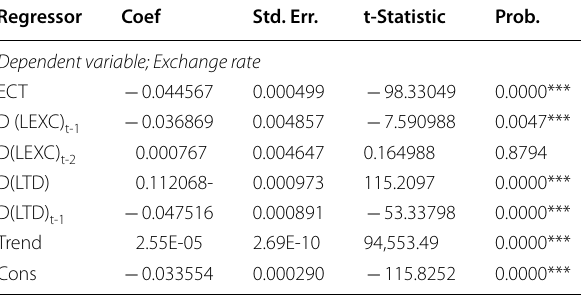
Table 10 Short-run estimates based on PMG for Italy